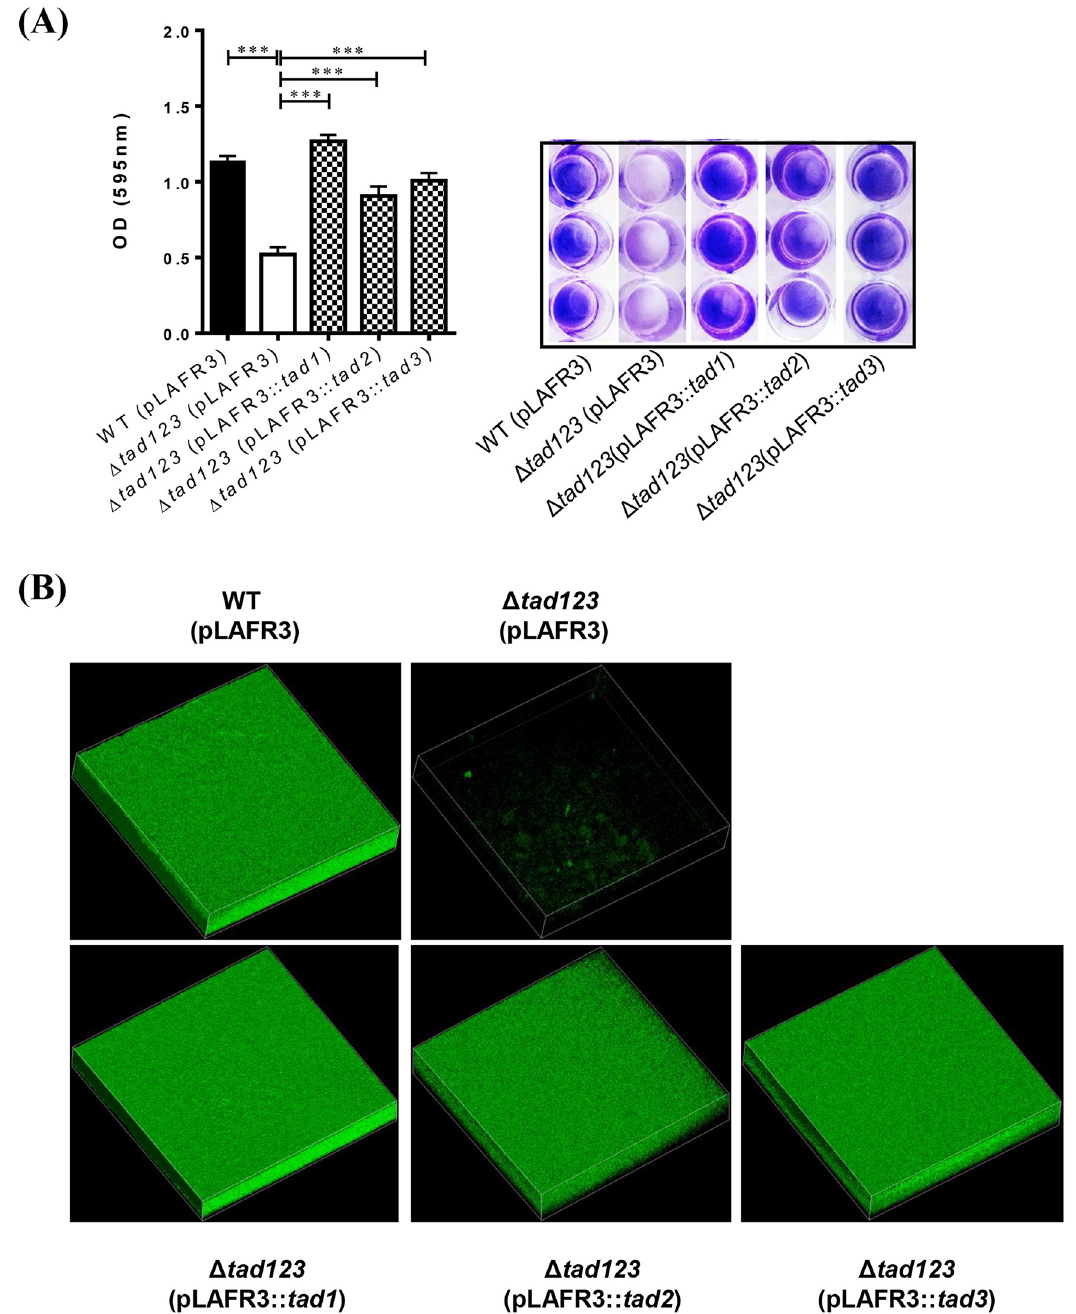
Fig 6. Decreased biofilm formation in the Δ tad123 mutant cells. (A) For biofilm formation, log-phase V . vulnificus cells (5x10 5 CFU/ml) was applied into each well of 24 well plate. The plates were further incubated at 37˚C for 24 hours. After gentle washing with PBS, the wells were stained with 200 μ l of 0.3% crystal violet for 15 min and gently washed with PBS. Data shown represent the mean ± SEM of three independent experiments performed with six replicates. The stained biofilm was extracted with 100% ethanol and diluted (two-fold) with PBS to measure the absorbance at 595 nm. (B) Confocal microscopic observation of the acridine orange- stained biofilm. WT (pLAFR3), wild type harboring pLAFR3; Δ tad123 (pLAFR3), Δ tad123 mutant harboring pLAFR3; Δ tad123 (pLAFR3:: tad1 ), Δ tad123 mutant in trans complemented with pLAFR3:: tad1 locus; Δ tad123 (pLAFR3:: tad2 ), Δ tad123 mutant in trans complemented with pLAFR3:: tad2 locus); Δ tad123 (pLAFR3:: tad3 ), Δ tad123 mutant in trans complemented with pLAFR3:: tad3 locus. Statistical analysis was carried out using Student’s t test. ��� , P < 0.001. WT, wild-type V . vulnificus